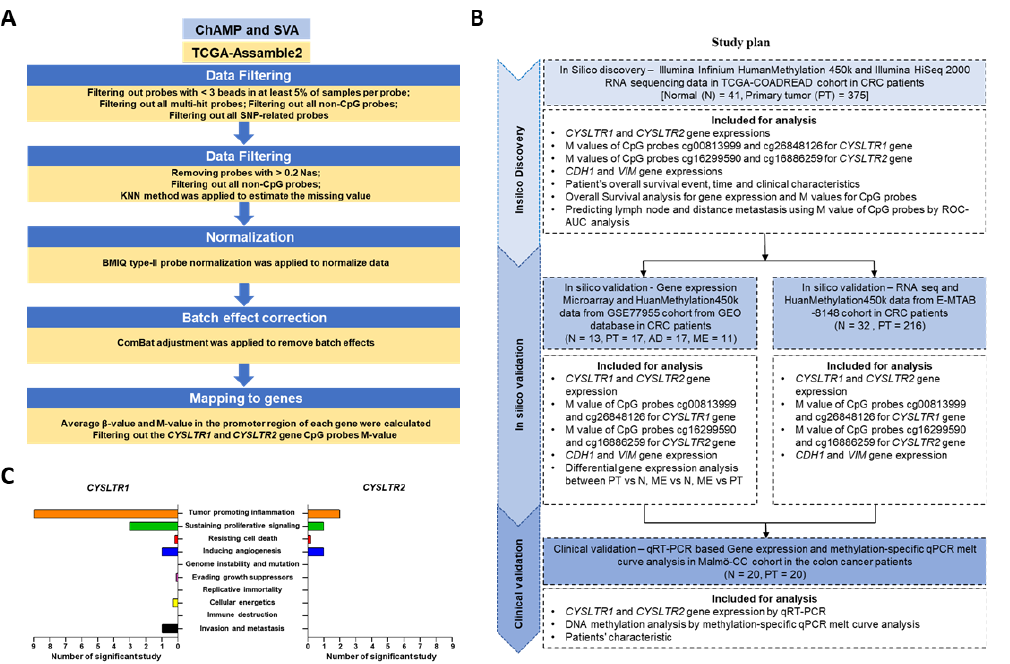
Figure 8. ( A ) Flowchart for CRC-specific DNA methylation data collection from TCGA-COADREAD dataset. ( B ) Flowchart for study designing, normal — N, adenoma — AD, primary tumor — PT and distant metastasis — ME. ( C ) The role of CYSLTR1 and CYSLTR2 in different cancer hallmarks based on different datasets and publications (based on the Cancer Hallmarks Analytics Tool (CHAT); http://chat.lionproject.net, accessed on 08 February 2022).